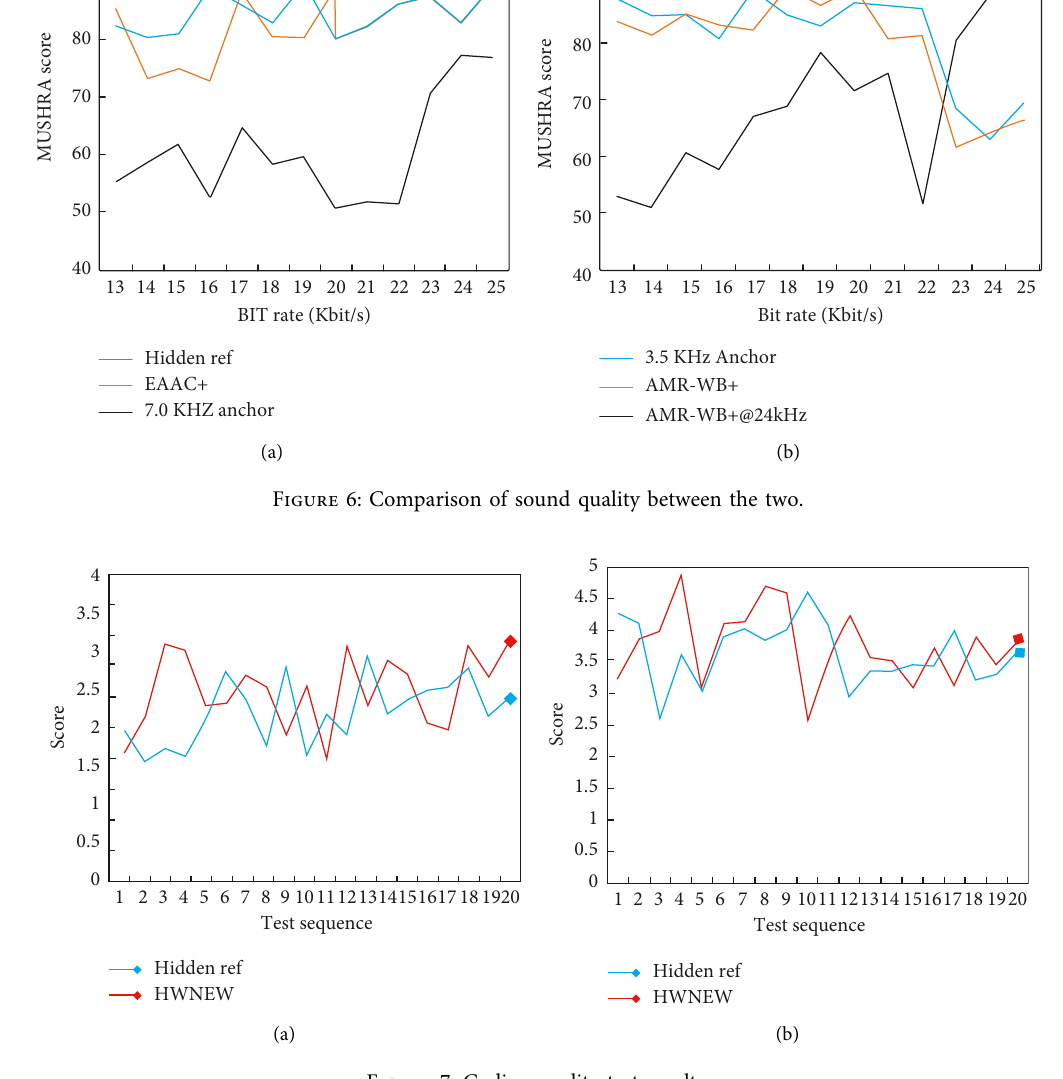
Figure 7: Coding quality test